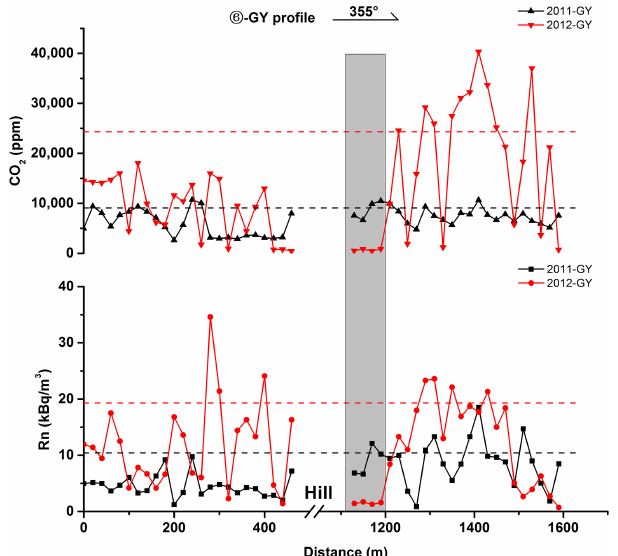
Figure 10. Rn and CO 2 concentrations along the FN profile across the Tangshan Fault. The shaded bar represents the location of the fault. The black and red dotted lines represent the anomaly threshold of soil gas in 2011 and 2012, respectively. The arrow at the top (with number above) represents the direction of the